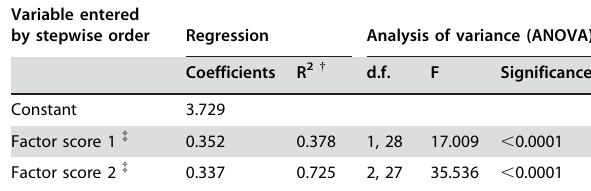
Table 2. Stepwise regression between number of